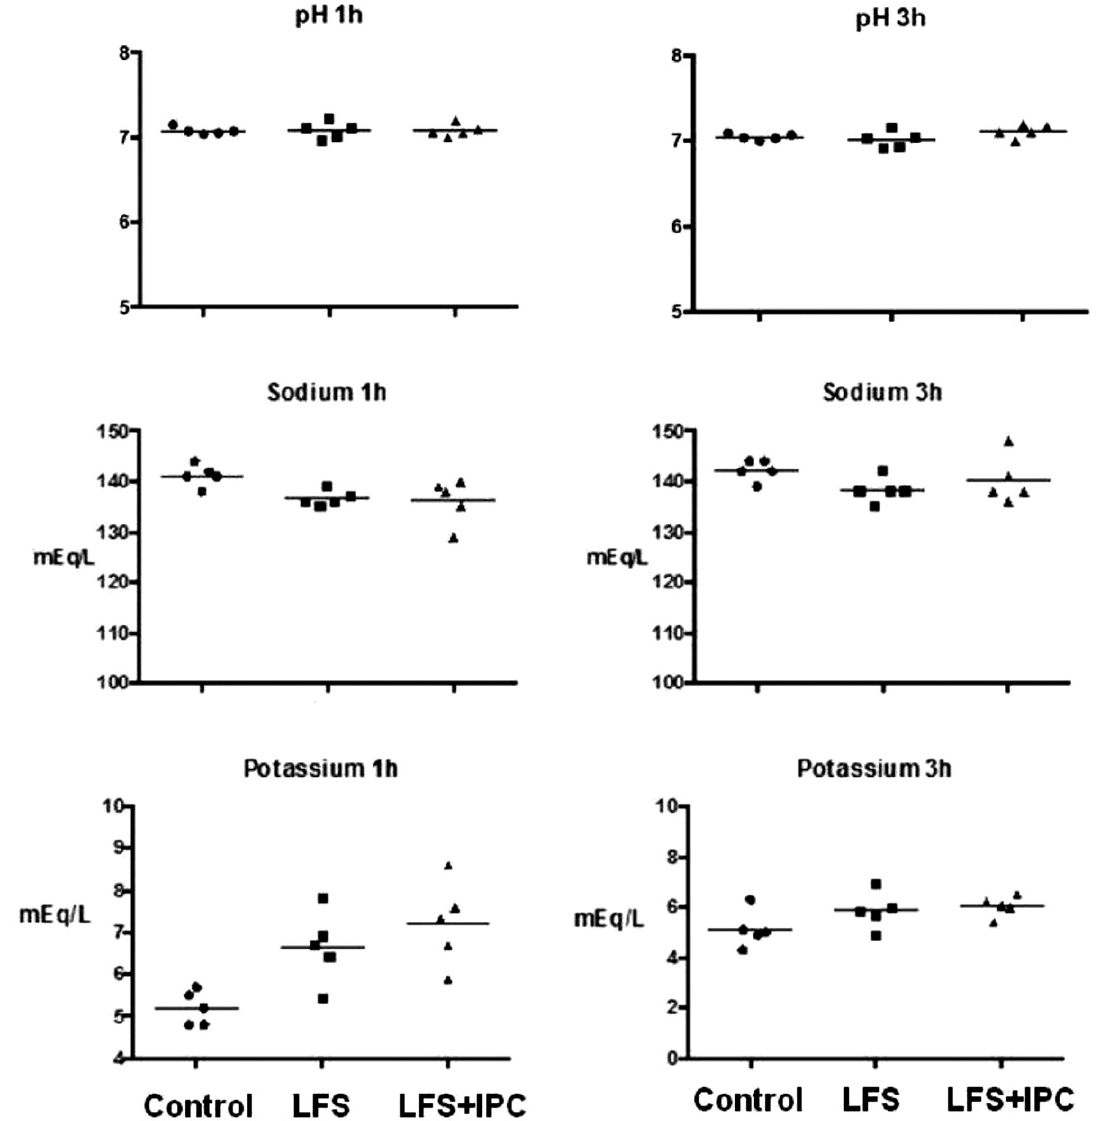
Figure 1 - The results of serum analyses. There were no differences in the pH values among the groups. Decreased serum levels of Na and increased serum levels of K were observed at 1 hour and 3 hours after reperfusion in the LFS and LFS + IPC groups compared with the control group ( p =0.021 and p =0.047 for Na values and p =0.028 and p =0.004 for K